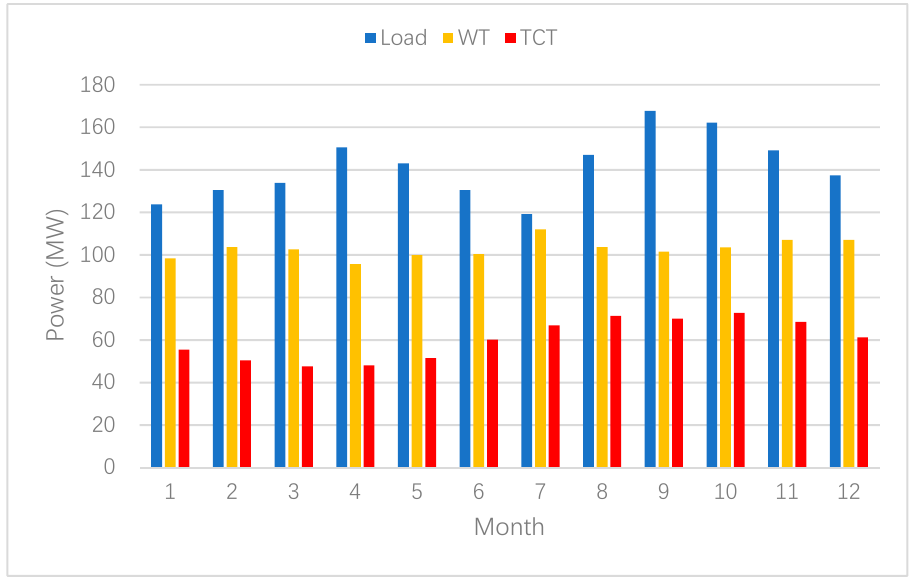
Figure 16. Components monthly electricity generation.